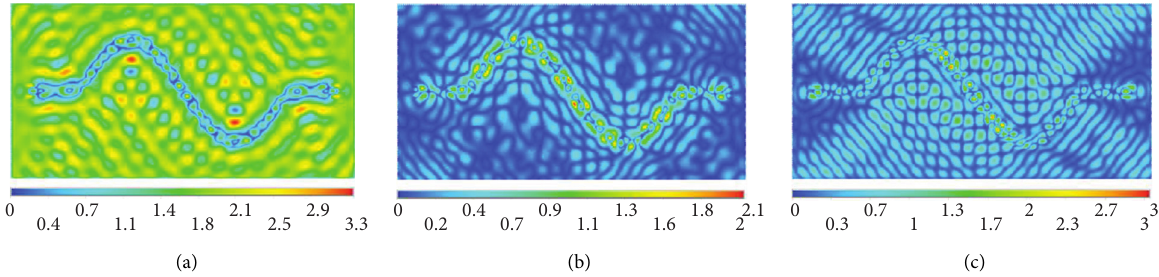
Figure 23: SV wave incident ( f � 4.0Hz, H � 100m, C